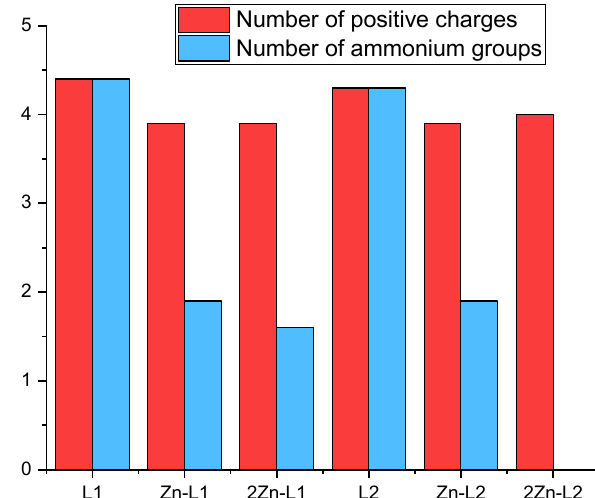
Figure 1. Average number of positive charges and number of ammonium groups at pH 7.4 (L = 1 × 10 − 5 M, Zn 2+ = 1 × 10 − 5 M and 2 × 10 − 5 M for Zn-L and 2Zn-L complexes, respectively) derived from the values of stability and protonation constants previously obtained by potentiometric titrations in aqueous solution at 298.1 K using NaCl 0.15 M as supporting electrolyte.